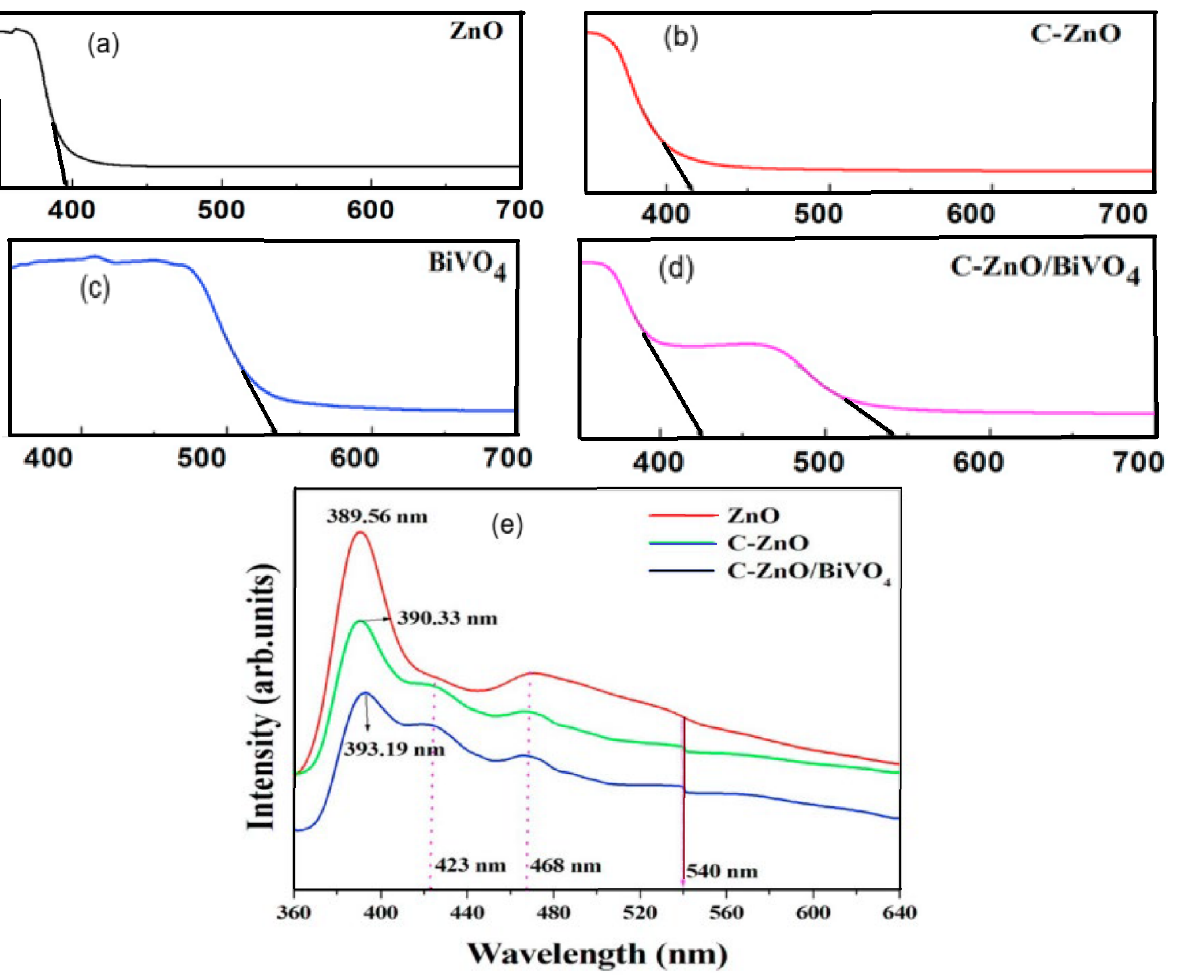
Figure 14. UV-DRS ( a – d ) and PL spectral data ( e ) of C-doped ZnO nanomaterials coupled with BiVO 4 [98].